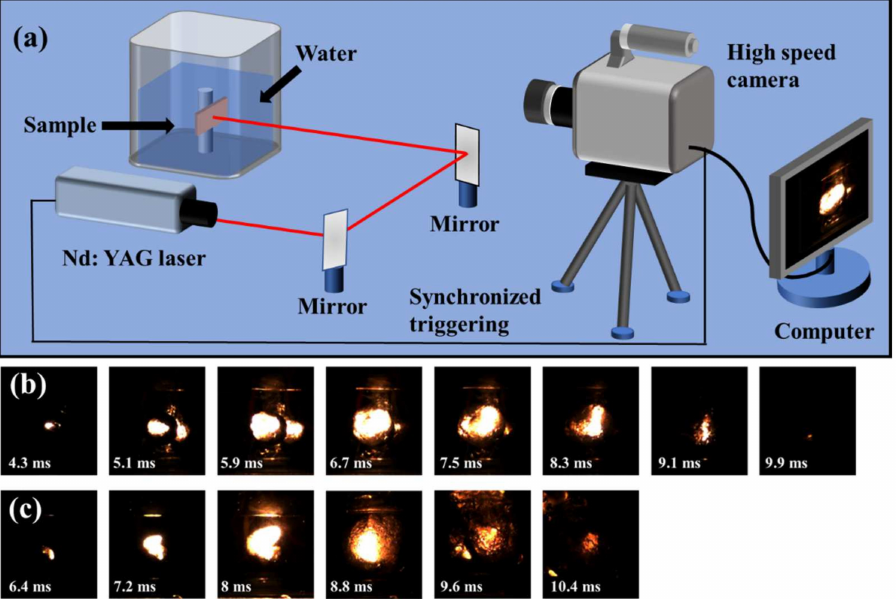
Figure 6. ( a ) The schematic diagram of the submerged ignition process; The snapshot for the